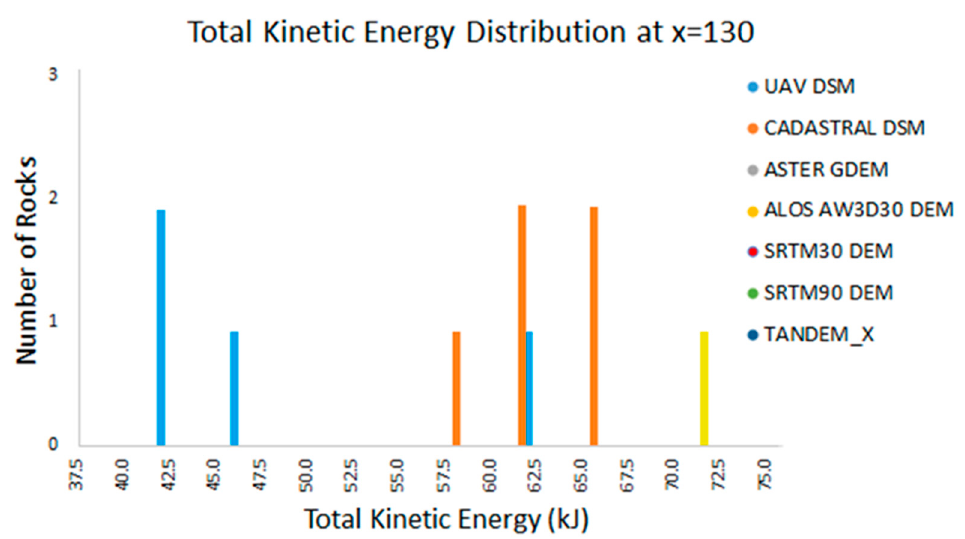
Figure 14. Total kinetic energy distribution at x = 130 m for the 2nd slope profile.